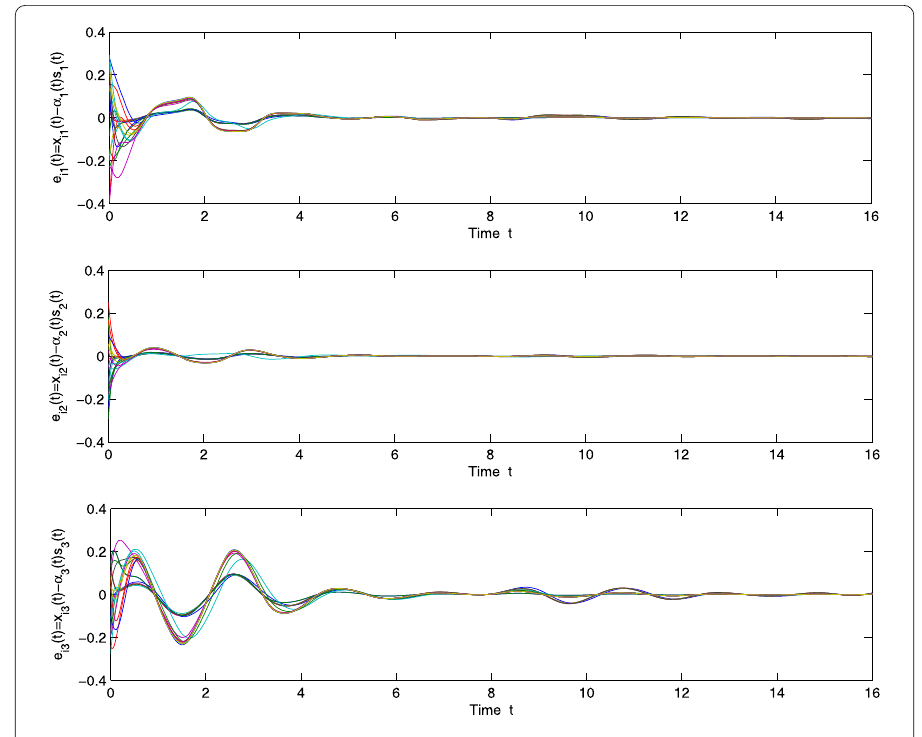
Figure 17 The modified function projective synchronization errors between the states of isolate node α ( t ) s ( t ) (38) and node x i ( t ) (39) with Watts-Strogatz network and hybrid adaptive pinning control.